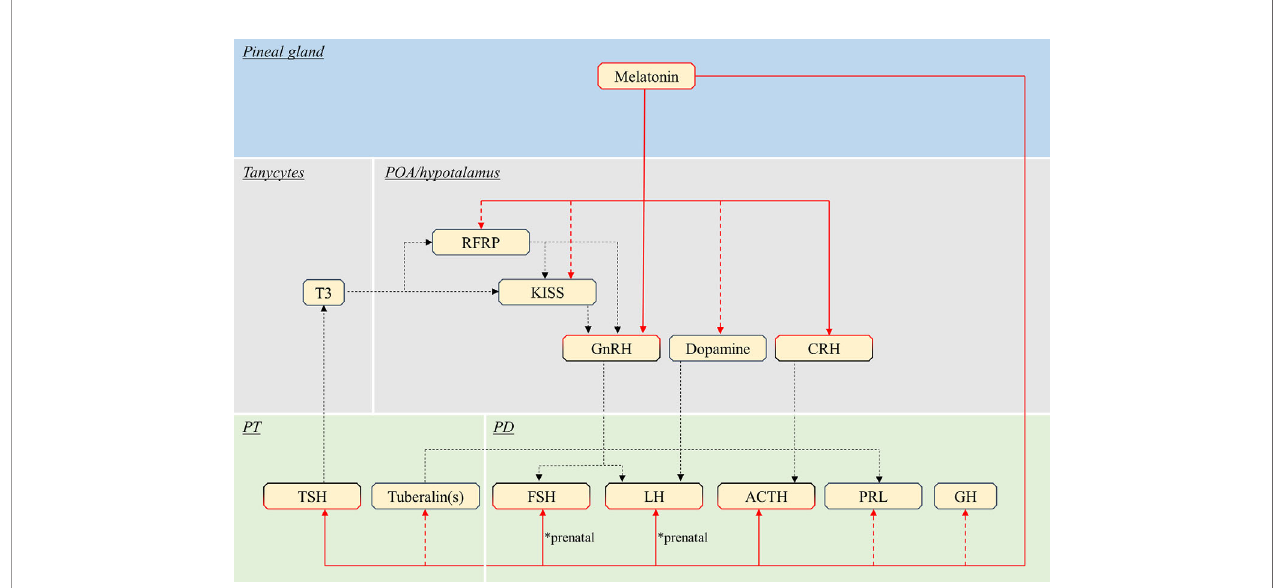
FIGURE 3 | Schematic view of the putative pathways through which melatonin in fl uence pituitary endocrine activity in mammals. Red continuous lines indicate cell types directly targeted from melatonin. Dashed red lines indicate cells in fl uenced by melatonin via yet unidenti fi ed interneurons, paracrine signals or MTNR. Note that melatonin might act only on a few of the illustrated pathway, in different species (see text). Black dashed lines indicate all other interactions between brain and pituitary. POA, preoptic area; PT, pars tuberalis ; PD, pars distalis ; T3, triiodothyronine; RFRP, RFamide-related peptide; KISS, kisspeptin; GnRH, gonadotropin- releasing hormone; CRH, corticotropin-releasing hormone; TSH, thyroid-stimulating hormone; FSH, follicle-stimulating hormone; LH, luteinising hormone; ACTH, adrenocorticotropic hormone; PRL, prolactin; GH, growth